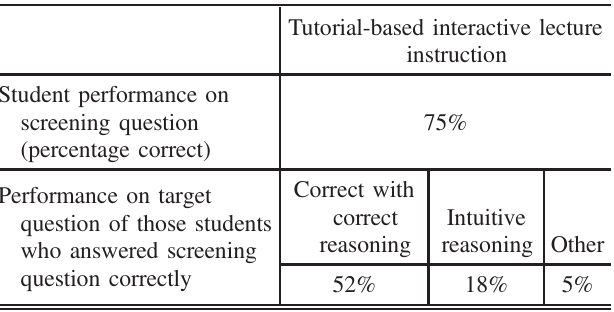
TABLE II. Student performance on the pulse at a junction between two different springs sequence. (All reported percent- ages are percentages of